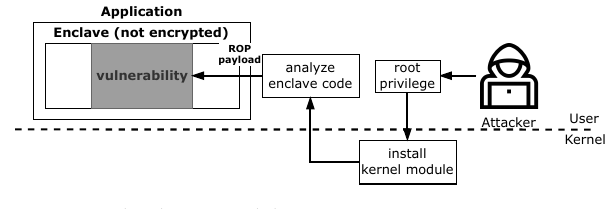
Figure 1. The threat